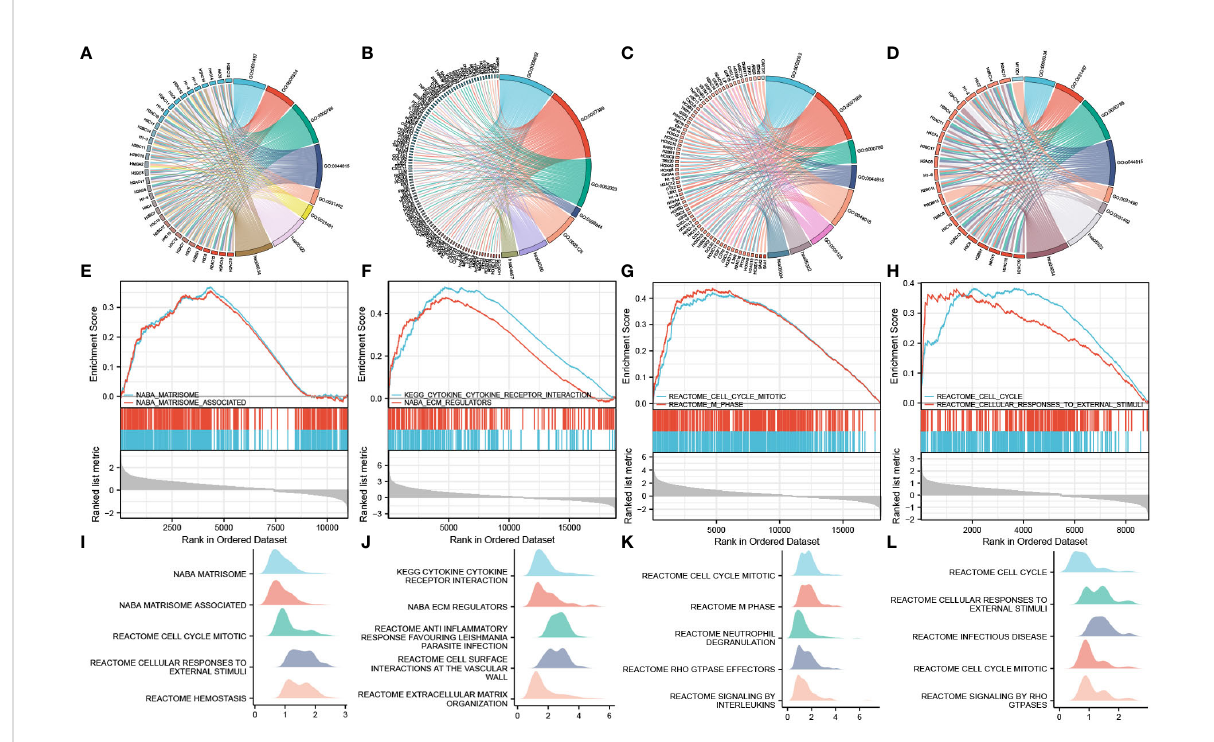
FIGURE 10 Combined GO and KEGG analysis of logFC value and GSEA analysis. The left side of the chord diagram is the genes used for the enrichment analysis, and the right side is the enrichment analysis result. Different result items are linked to corresponding genes and are distinguished by different colors. (A – D) H2BC5, H2BC9, H2BC11, and H2BC21 were divided into high- and low-expression groups, and the logFC value was combined for GO and KEGG analysis. (E – H) H2BC5, H2BC9, H2BC11, and H2BC21 were divided into high- and low-expression groups, and GSEA analysis was performed. (I – L) Other GSEA analysis results are shown in mountain